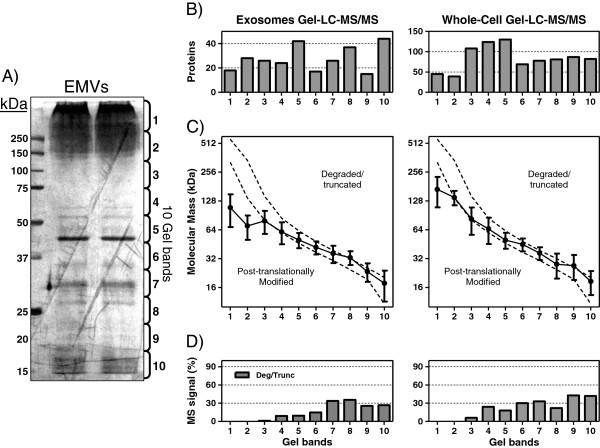
Gel-LC MS/MS of HBEC-EMV proteins. (A) Coommassie blue-stained gel following SDS-PAGE analysis of EMVs from HBEC. Shown are the molecular weight (MW) markers (left) and the position of ten bands that were cut out (right). (B) Total number of proteins identified in each band from SDS-PAGE of EMVs (left) or whole-cell HBEC extract (right). (C) Average theoretical MW (± SD) of the proteins in each gel band. The dotted lines represent the observed MW range of gel band, as determined by marker lane. If the theoretical MW is above the upper dotted line, it is likely degraded/truncated, whereas if it is below the lower dotted line, it is potentially post-translationally modified. Note the log scale. (D) Percentage of MS signal originating from degraded/truncated proteins in each gel band as described in panel C.